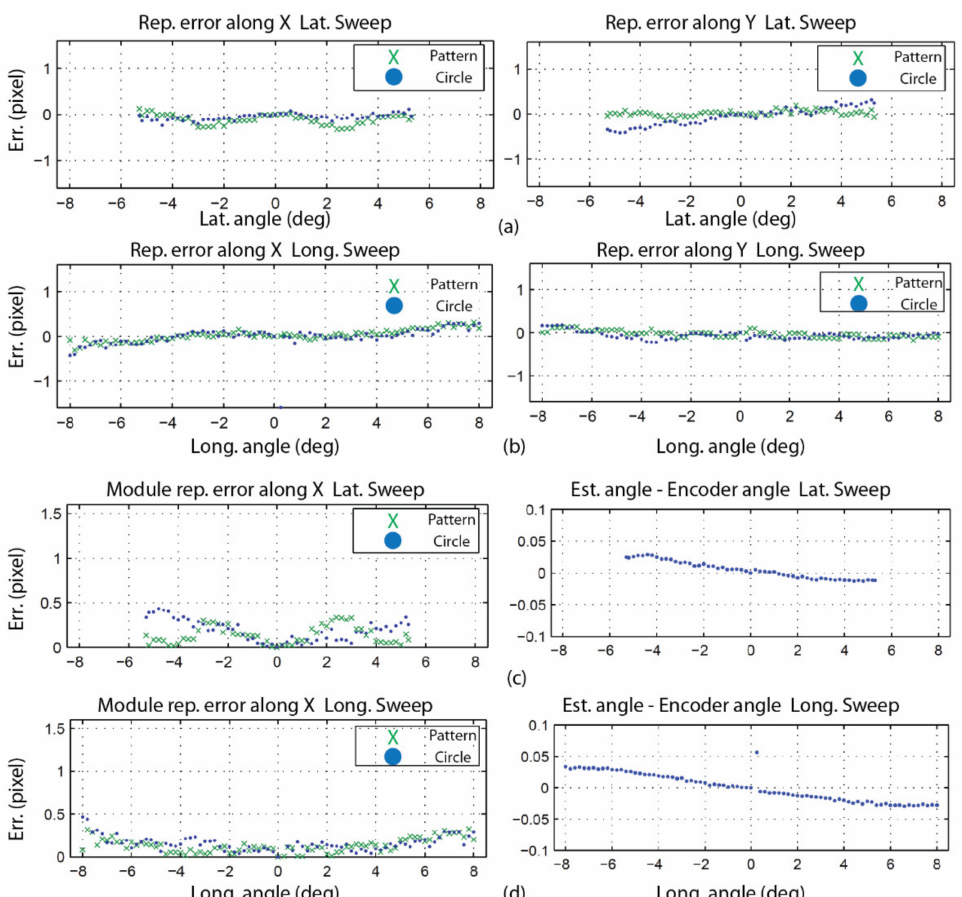
Figure 33. Results of the calibration of a two-axis system for the right eye showing the reprojection error for the principal sweep along the latitudinal axis ( a ) and the longitudinal axis ( b ). One can check that the error is smaller than 0.5 pixels for each axis. Module of the reprojection error and difference between the estimated angle and the angle read on the encoders for the latitudinal axis ( c ) and the longitudinal axis ( d